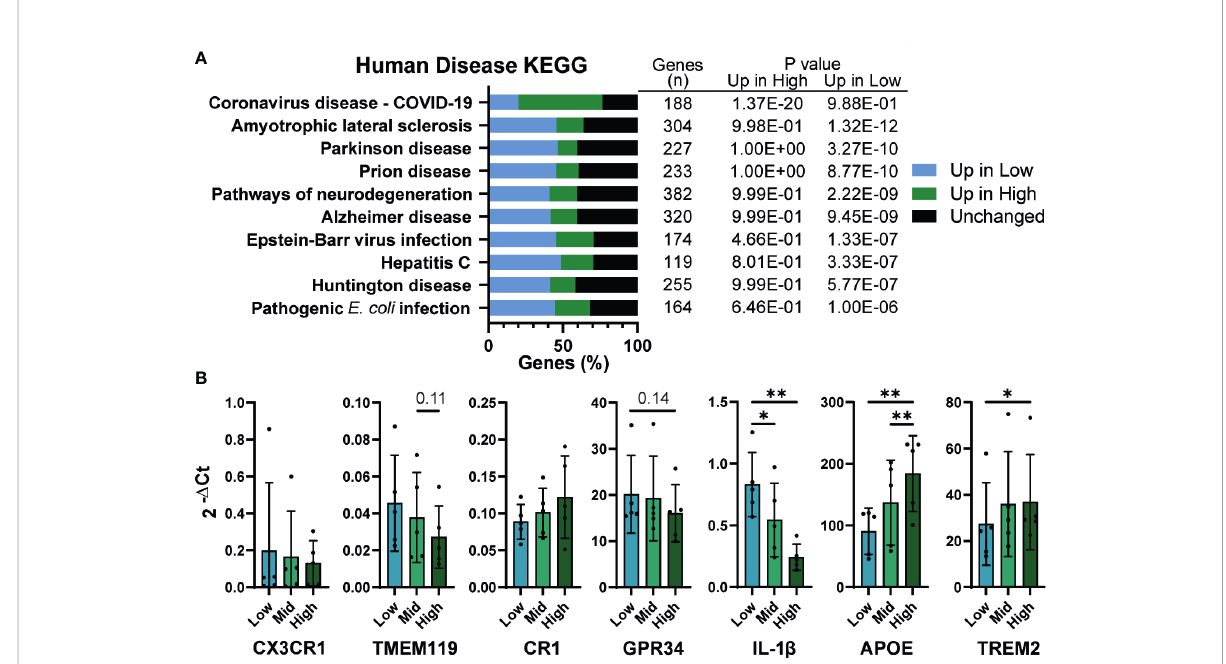
FIGURE 7 Density in fl uences in vitro modeling of neurodegenerative diseases (A) Human disease related KEGG term analysis of differential gene expression comparing high vs low density plated iPSC-Mac. Bars indicate proportion of genes in a given term that are upregulated at each density or unaffected. Number of genes per term, and P value for enrichment at each density are shown in the adjoining table. (B) iPSC-derived microglia differentiation is in fl uenced by density. qPCR for microglial genes and genes related to Alzheimer ’ s disease. n=5, Two-way ANOVA, Tukey ’ s multiple comparisons test, with Greenhouse-Geisser correction. Signi fi cance is de fi ned as * <0.05, **